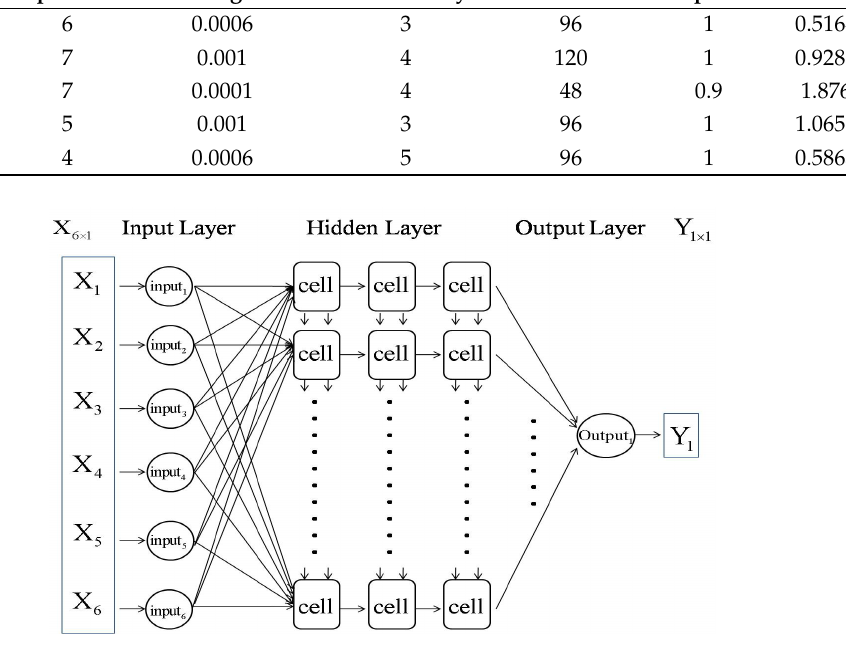
Figure 3. The structure of LSTM neural